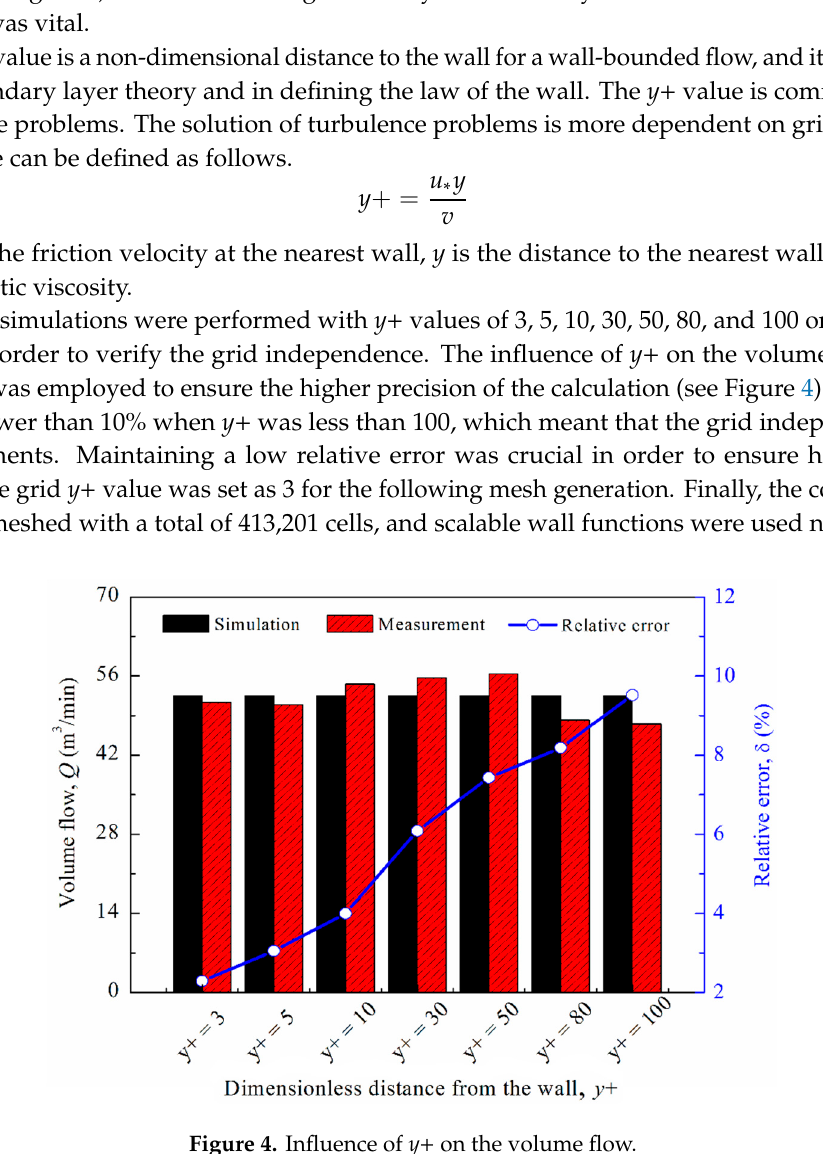
Figure 5. Influence of reverse-blowing flow rate on the total dust-collection efficiency. When the flow rate was low, the particles were easily blown near the suction inlet. Therefore, the particles could be picked up. For higher flow rates, firstly, the movement of the particles from reverse-blowing outlet to dust suction port was affected. Secondly, excessive flow rates gave the